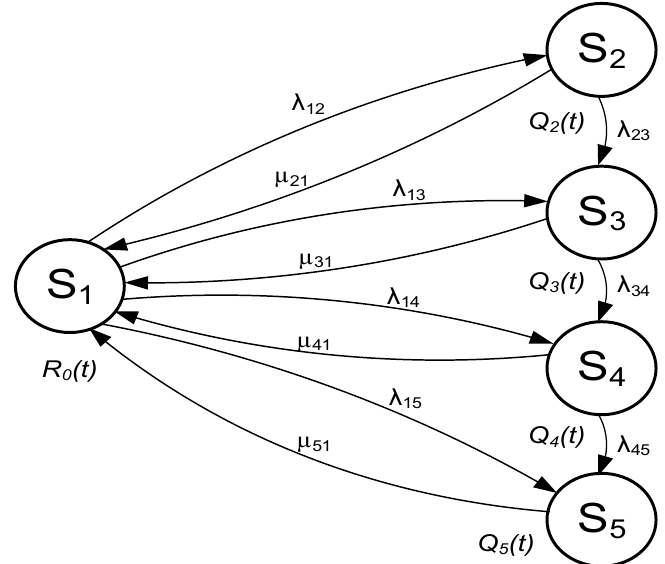
Figure 3. Operational model of a wind farm facility in the WFD system—own study.